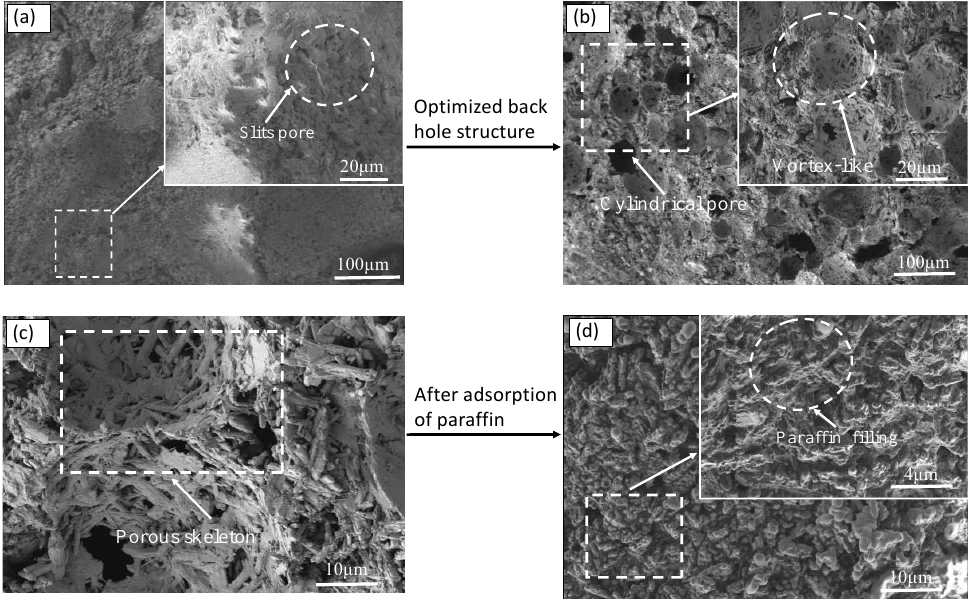
Figure 8. SEM images: ( a ) PBG; ( b , c ) PPBG; ( d ) ESPBG.